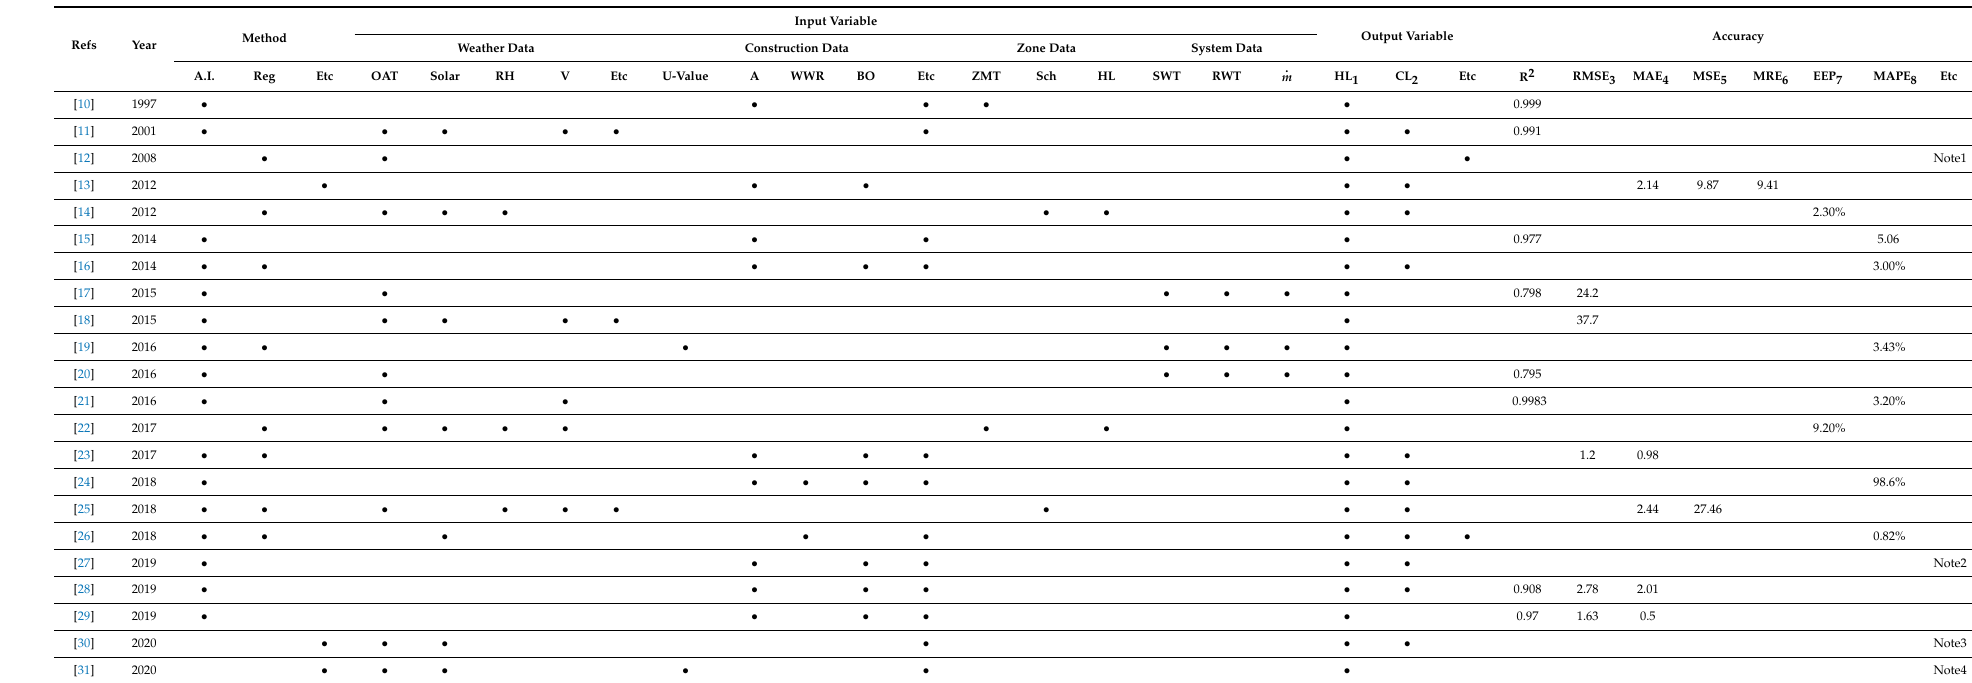
Table 1. Literature review of the prediction of heating